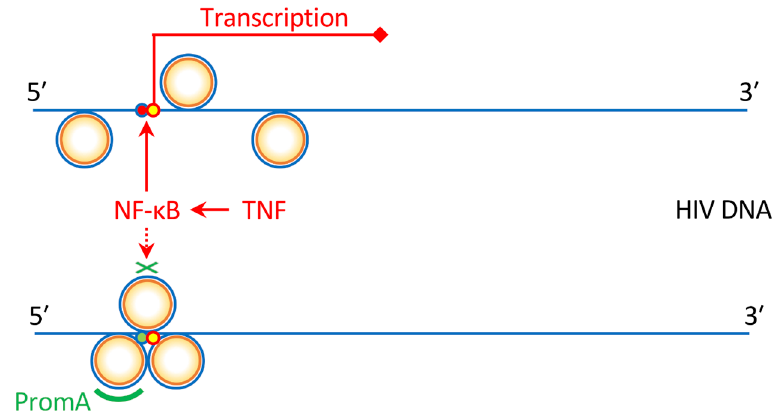
Figure 2. A schematic overview of PromA. PromA induces chromatin compaction in the human immunodeficiency virus (HIV)-1 promoter. This prevents HIV-1 DNA from reactivation, such as NF- κ B-mediated reactivation by tissue necrosis factor (TNF). For details on the molecular mechanisms involved in transcriptional gene silencing induced by PromA, see Klemm et al., 2016 [31] and Mendez et al., 2018 [32] .